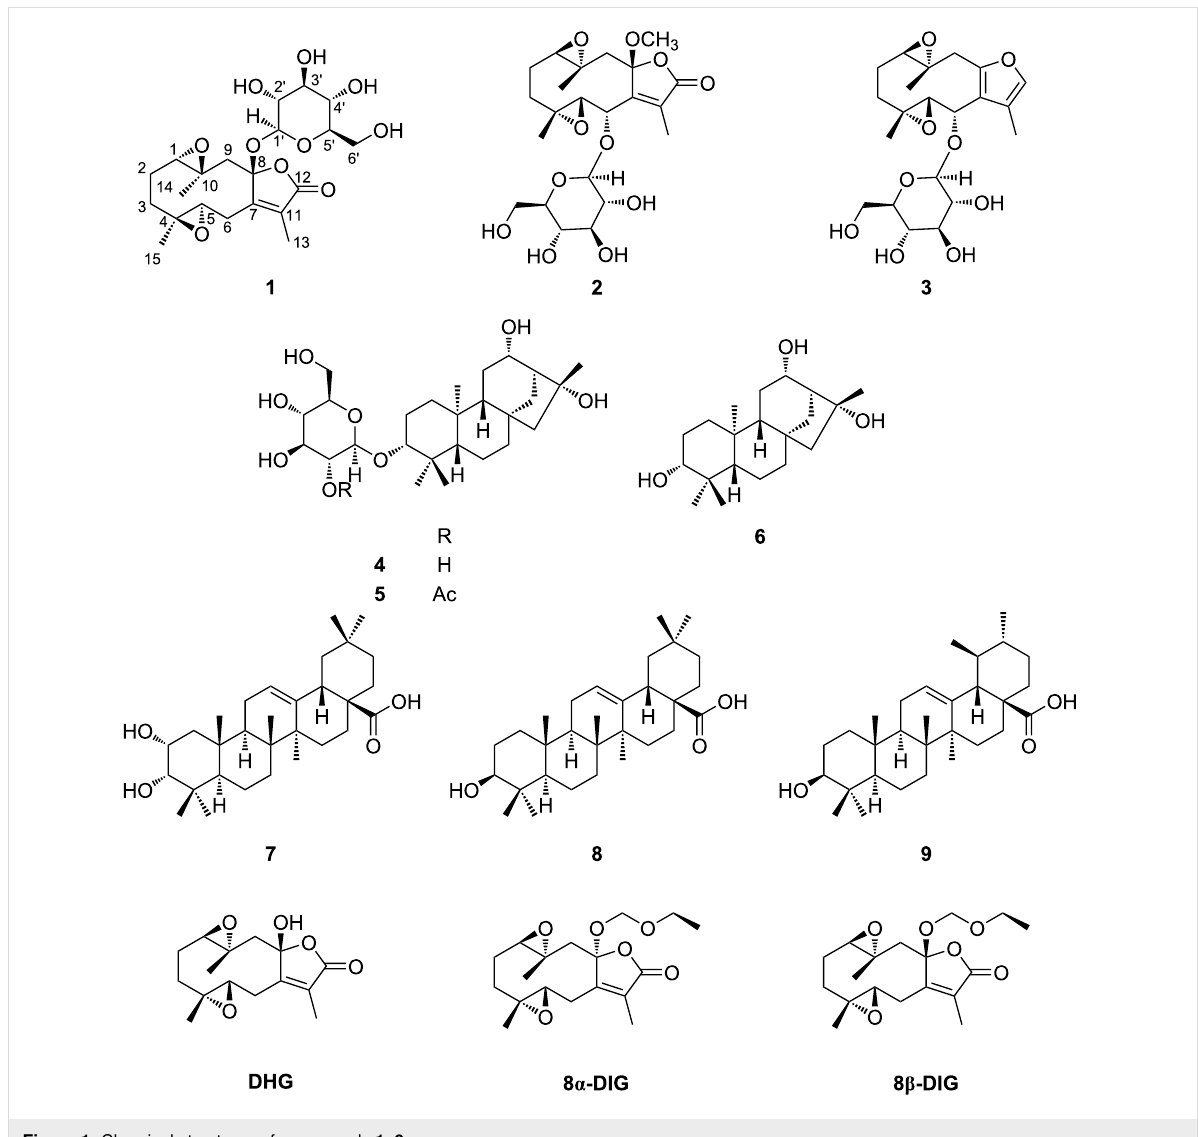
Figure 1: Chemical structures of compounds 1–9